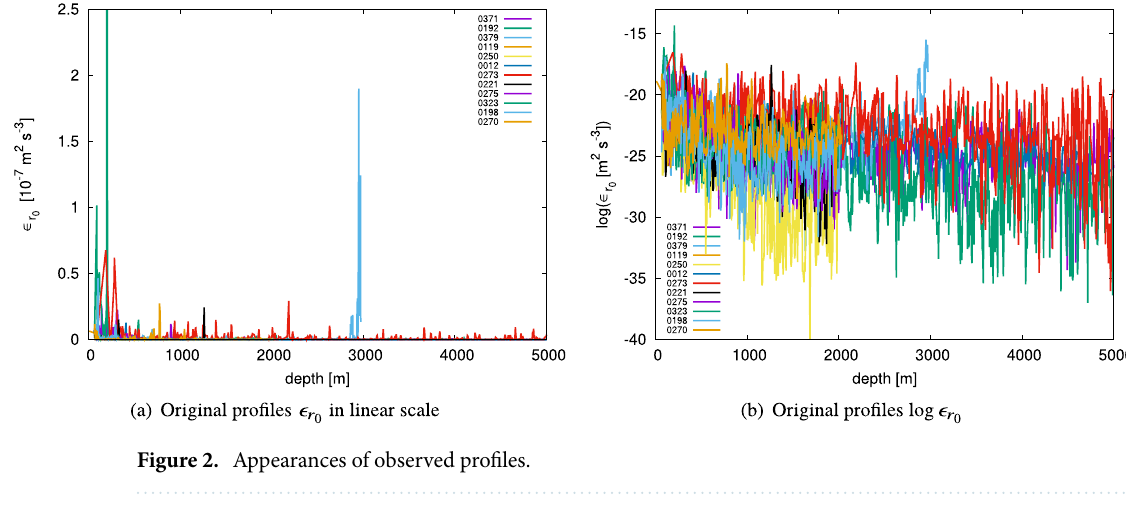
Figure 2. Appearances of observed